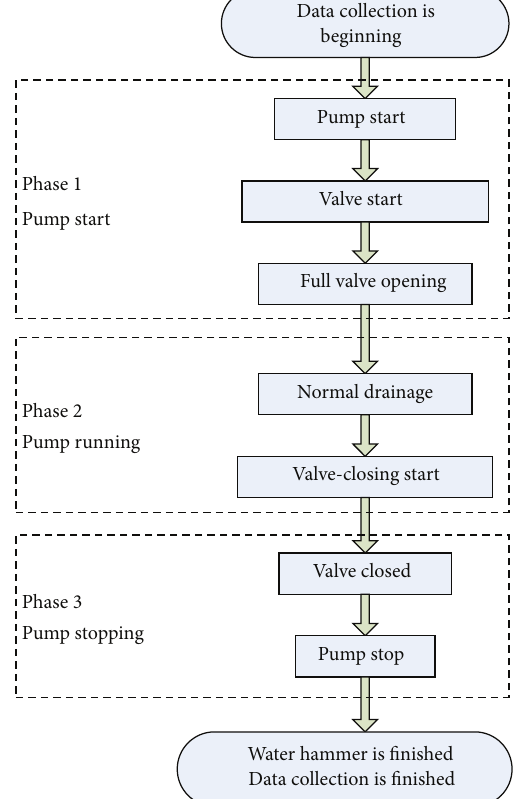
Figure 22: The flow chart of test for